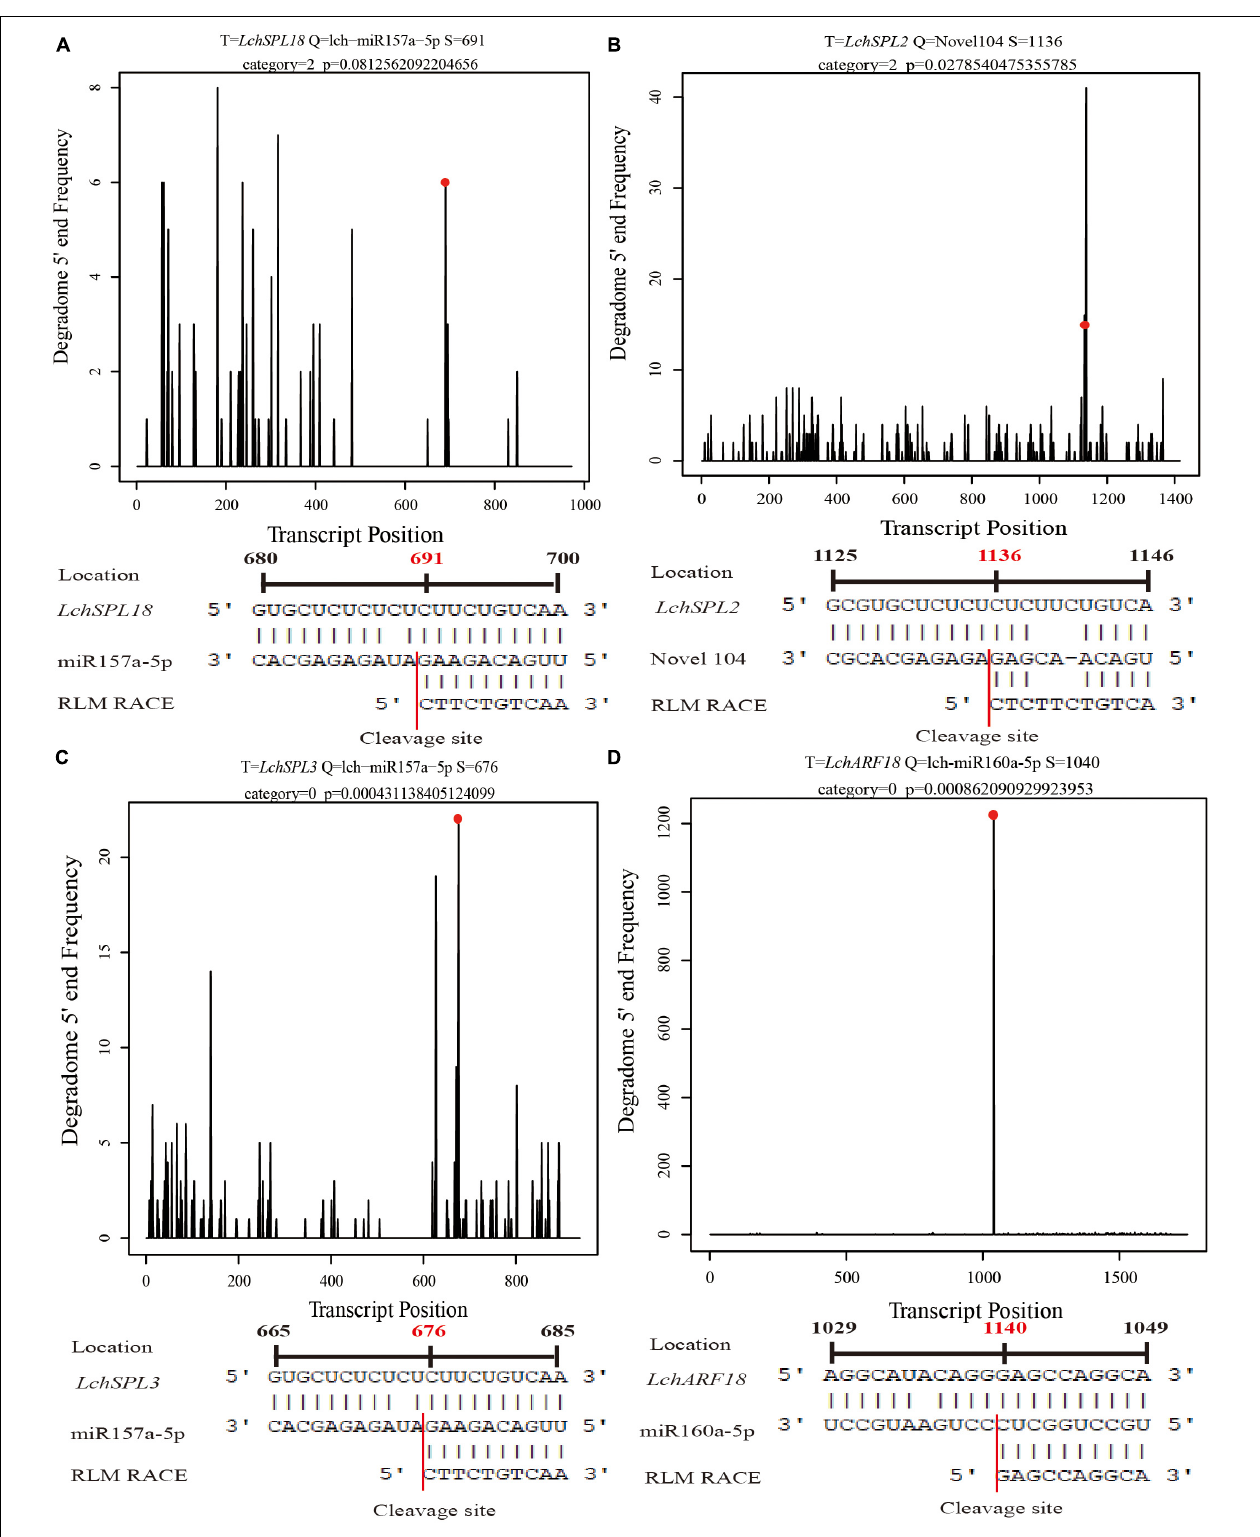
FIGURE 5 | RLM-RACE validation of the cleavage sites of miRNAs. Red dots and red numbers represent the first nucleotide of the 3 (cid:48) cleavage fragments predicted by degradome sequencing, and red lines represent the cleavage sites of miRNA validated by RLM-RACE. (A–D) RLM-RACE validation of the cleavage sites of lch-miR157a-5p, Novel104, lch-miR157a-5p, and lch-miR160a-5p in LchSPL18 , LchSPL2 , LchSPL3 , and LchARF18 , respectively.